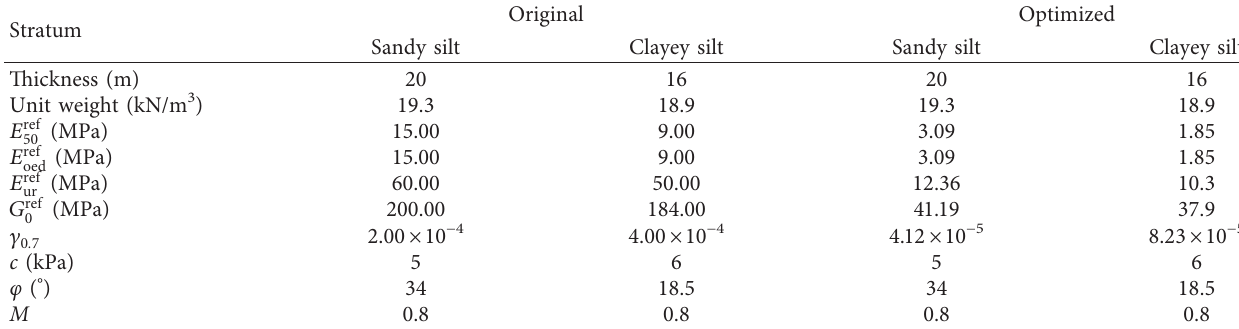
Table 5: Soil parameters before and after inverse